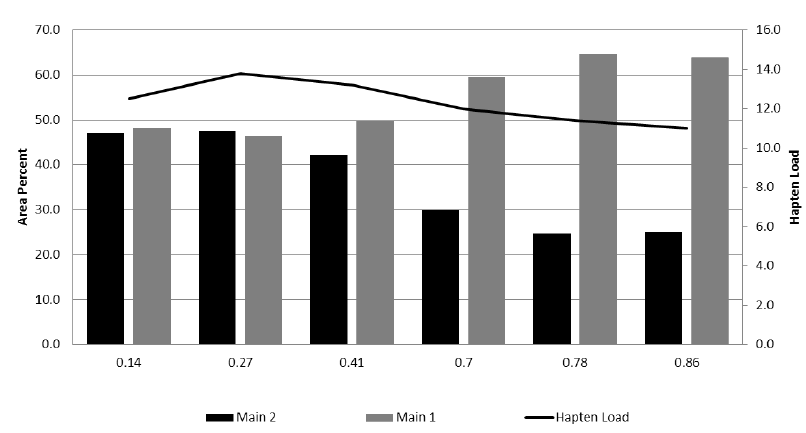
Figure 3. The effect of varying sNHS/EDC ratios on Main 1, Main 2, and hapten load. The amounts of Main 1 and Main 2 for conjugates at each ratio were determined by integrating the area under the peaks from SE-HPLC. Main 1 is represented by the light gray columns, and Main 2 by the dark gray columns. The hapten load for each sample as determined by acid hydrolysis is shown by the curve.